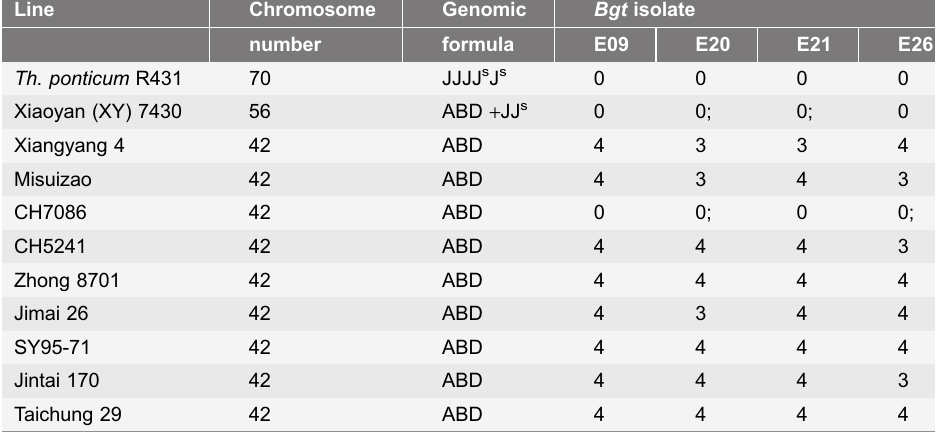
Infection types were based on a 0–4 scale, where 0 5 no visible symptoms, 0; 5 necrotic flecks, 1 5 necrosis with low sporulation, 2 5 necrosis with moderate sporulation, 3 5 no necrosis with moderate to high sporulation, and 4 5 no necrosis with full sporulation. Scores of 0–2 were classified as resistant and 3–4 as